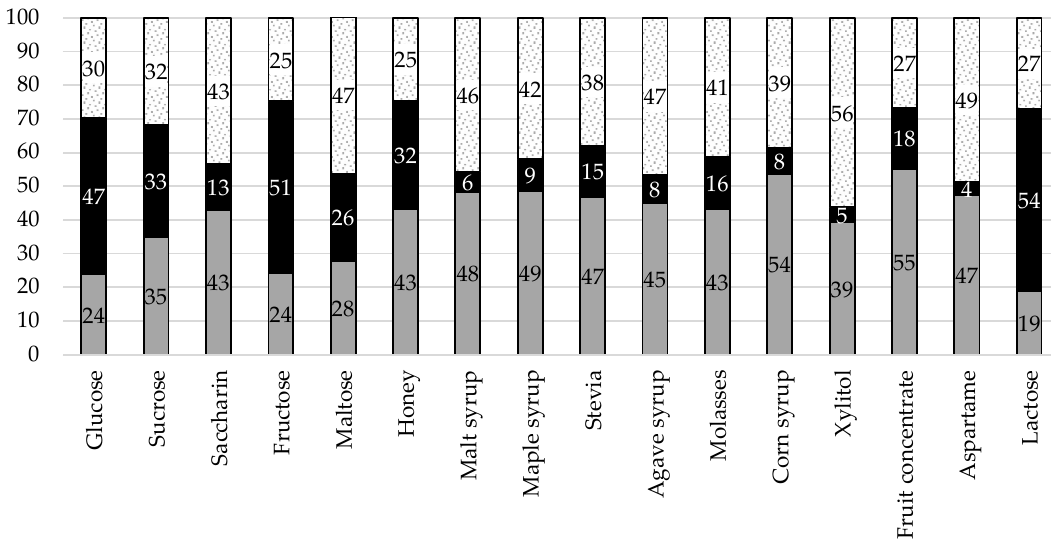
Figure 3. Categorization of sugar sources according to composition.